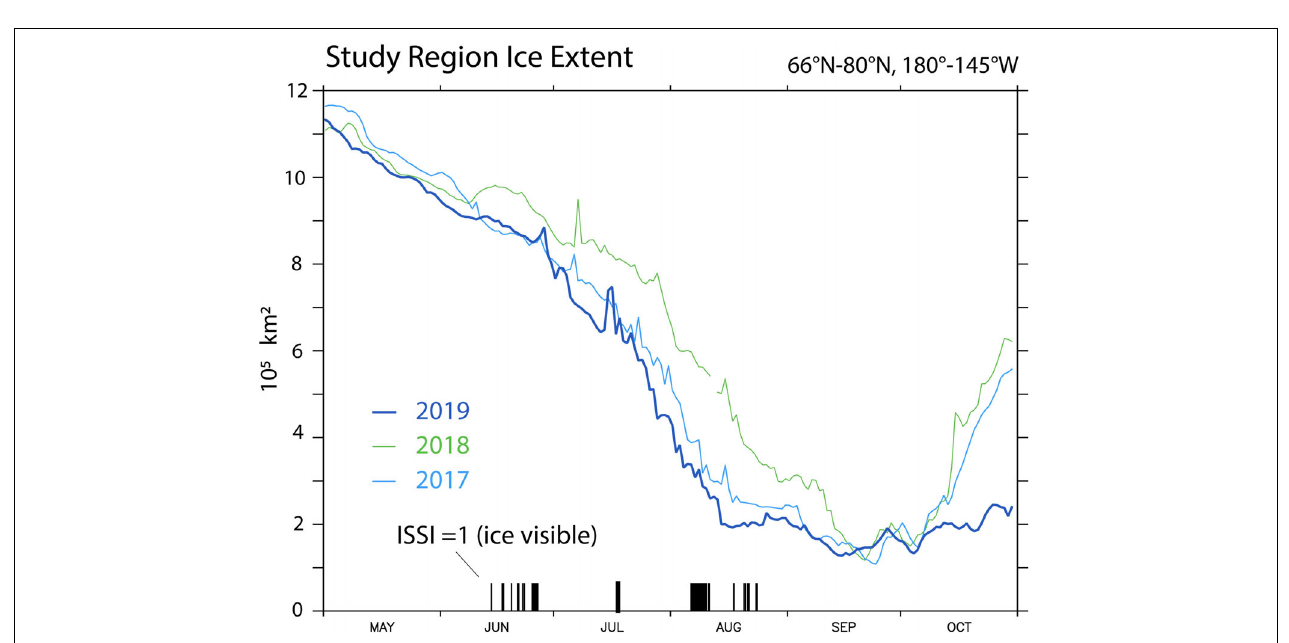
FIGURE 4 | Sea ice extent over the Chukchi and Beaufort Sea study region (180 ◦ –145 ◦ W, 66 ◦ –80 ◦ N) from the AMSR2 based ice concentration estimate provided by the EUMETSAT ocean and sea ice satellite application facility. Vertical lines on the time axis mark times when ISSI = 1, that is, sea ice was visible in either the horizontal or downward saildrone images. ISSI = 0 (images were ice-free) during all other times, which are not marked by vertical lines.